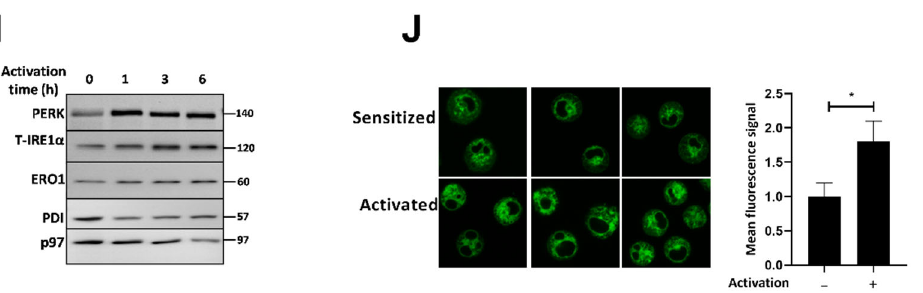
Figure 3. PMC activation through Fc ε RI promotes expression of IRE1 α without UPR activation. ( A ) WT PMCs were sensitized with mouse IgE-anti-DNP (0.5 µ g/mL, 18 h) and then activated with DNP-BSA (50 ng/mL, 4 h). Equal amounts of whole cell extracts were analyzed by immunoblotting for total IRE1 α , phosphorylated and total JNK, and p97 as a loading control. A typical immunoblot is shown. ( B ) WT PMCs were treated for 4 h as mentioned in ( A ) or treated with Tg (1 µ g/mL) as a positive control. Equal whole cellular protein extracts were analyzed by immunoblotting for phosphorylated and total IRE1 α , and p97 as loading control. Shown is a representative image of three independent experiments. ( C ) RT-qPCR analyses of IRE1 α , ( D ) sXBP1, and ( E ) ERdj4 following 4 h of activation represented as the average of the mRNA levels normalized to GAPDH ± SD. ( F ) PMCs were sensitized with rat myeloma IgE (1 µ g/mL, 18 h) followed by activation with goat anti-rat IgG F(ab’) 2 Ab (1 µ g/mL, 4 h). Identical quantity of total cellular protein extracts was analyzed by immunoblotting against total IRE1 α and p97 as a loading control. ( G ) IgE sensitized WT PMCs with IgE-anti-DNP (0.5 µ g/mL, 18 h) were pretreated with 3 µ M JNK-IN-8 for 1 h followed by activation with DNP-BSA (50 ng/mL, 4 h). An identical quantity of total cellular protein extracts was analyzed by immunoblotting against total IRE1 α , PERK, and p97 as a loading control. ( H ) WT PMCs were sensitized with mouse IgE–anti-DNP (0.5 µ g/mL, 18 h), followed by activation with DNP-BSA (50 ng/mL) for 1, 3, 6, or 24 h. An identical quantity of protein was analyzed by immunoblotting against PERK, total IRE1 α , and p97 as a loading control. ( I ) WT PMCs were sensitized with mouse IgE–anti-DNP (0.5 µ g/mL, 18 h), followed by activation with DNP-BSA (50 ng/mL) for 1, 3, and 6 h. Equal amounts of whole cell extracts were analyzed by immunoblotting for PERK, total IRE1 α , ERO1, PDI, and p97 as a loading control. ( J ) Fluorescence of ER-Tracker in PMCs following IgE-mediated activation for 4 h, analyzed by confocal microscopy at magnification of 60 × with immersion oil. Mean fluorescence signal from 50 cells was quantified using ImageJ 1.53t software (U. S. National Institutes of Health, Bethesda, MD, USA). The average intensity and standard deviation are shown. * p <